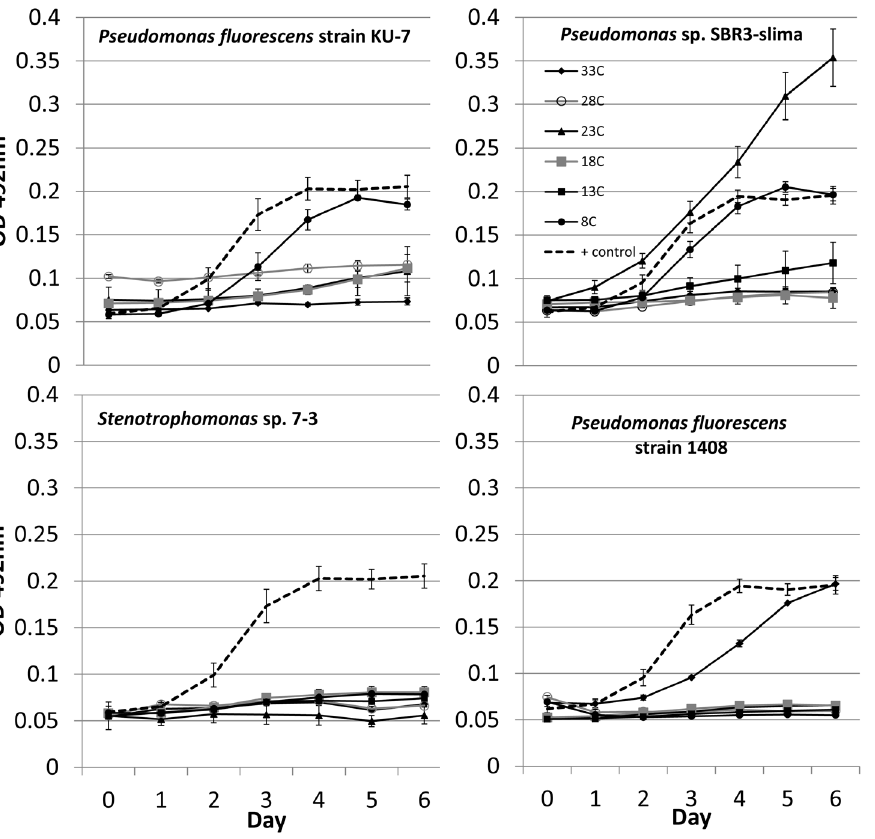
Figure 3. Growth curves (uncorrected optical density at 492 nm, OD 492 nm) vs. day of the experimental challenge assay for Bd growth in cell-free supernatants from four bacteria chosen as examples to show the range of responses observed following the temperature treatments applied during cell-free supernatant production. Values are means 6 SD. Where not visible, SD bars are smaller than the plotted symbols. All bacterium-temperature combinations have N=5 replicates in the challenge assay, except P. fluorescens with N=4 at 23 u C and 18 u C, N=3 at 33 u C and no data at 13 u C due to contamination. Cell-free supernatants were produced once at each temperature.